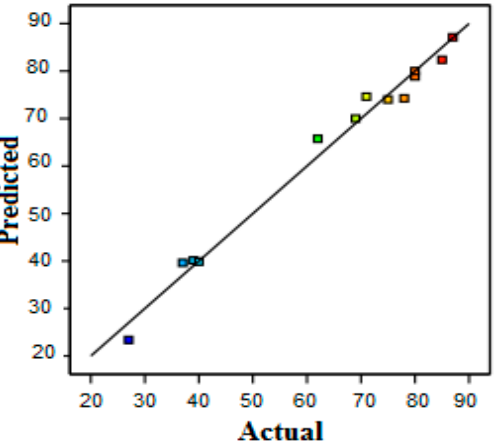
Figure 3. Comparison of calculated and predicted values for protein removal using RSM. The difference of color for the dots is due to the difference between min and max values of the parameter: min in blue and max in red (given by the software).